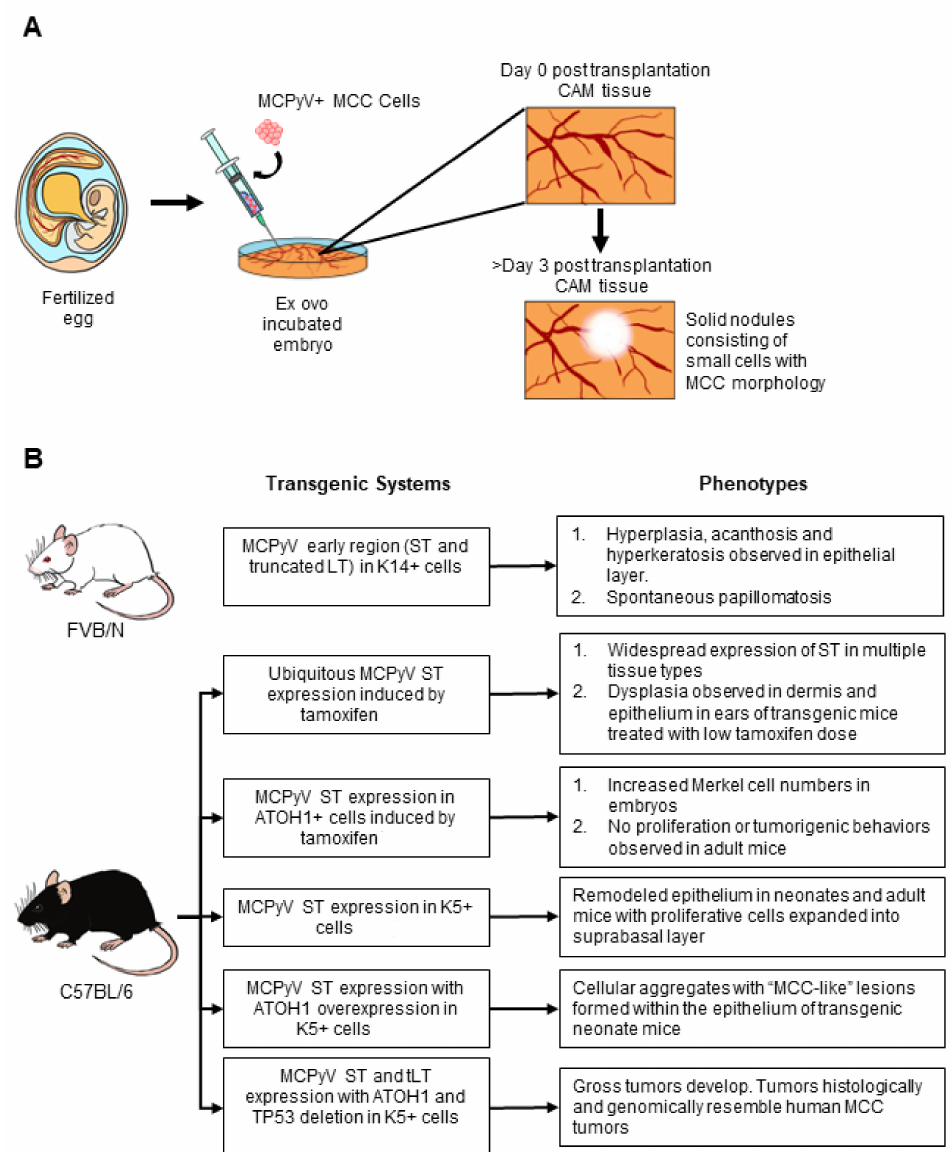
Figure 4. In vivo models for MCPyV+ MCC. ( A ) Short-term MCPyV+ MCC in vivo model with chick chorioallantoic membrane (CAM) assay as described in Bhat et al. [167]. Fertilized eggs were